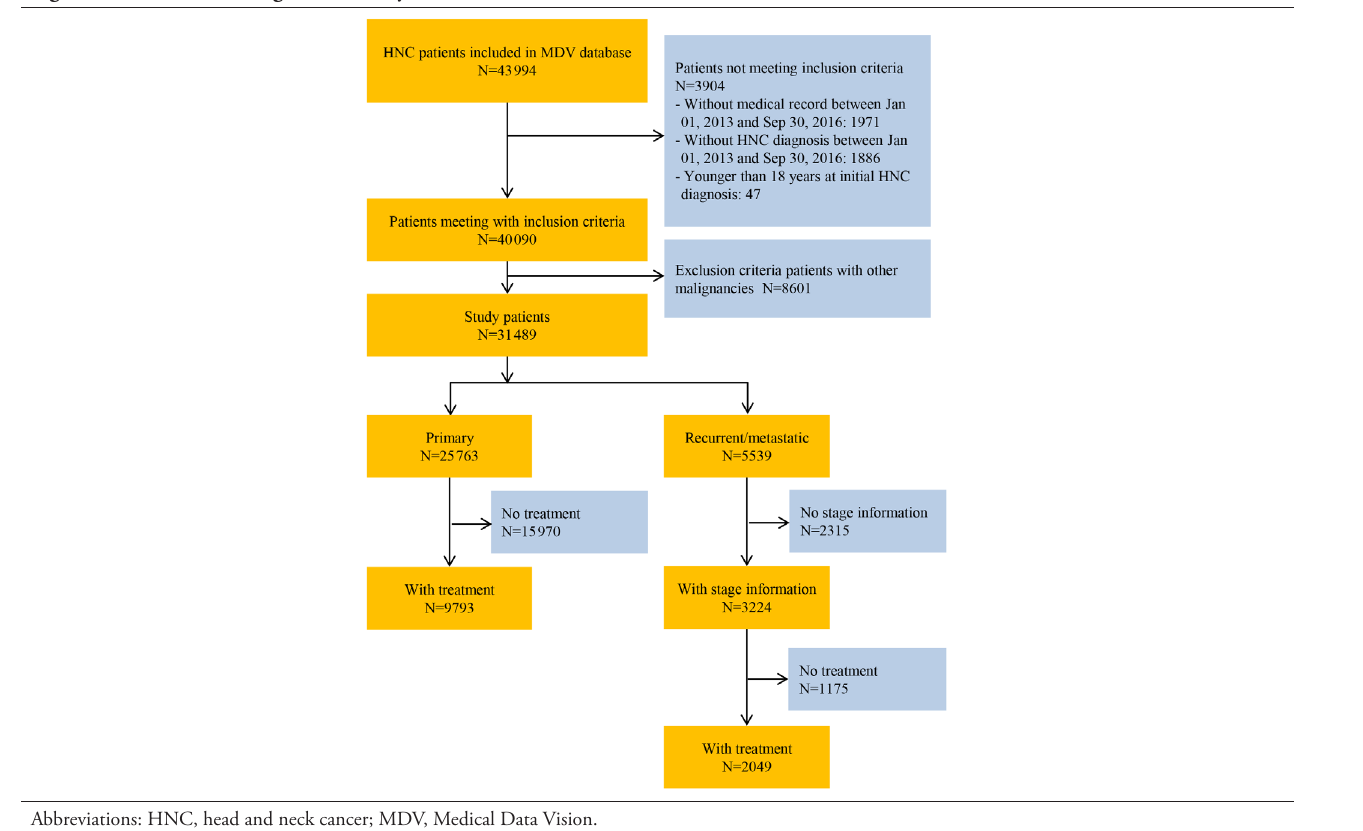
Abbreviations: HNC, head and neck cancer; MDV, Medical Data Vision. Figure 2. Patient Flow Diagram (Platinum-Refractory HNC)